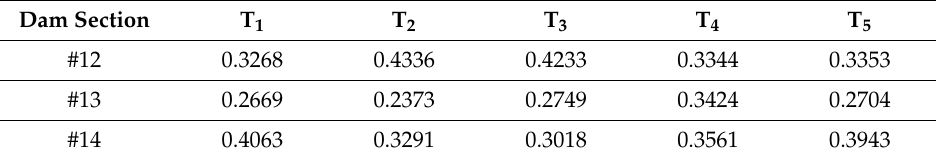
Table 9. The weight variation of monitoring items for the dam section #13.